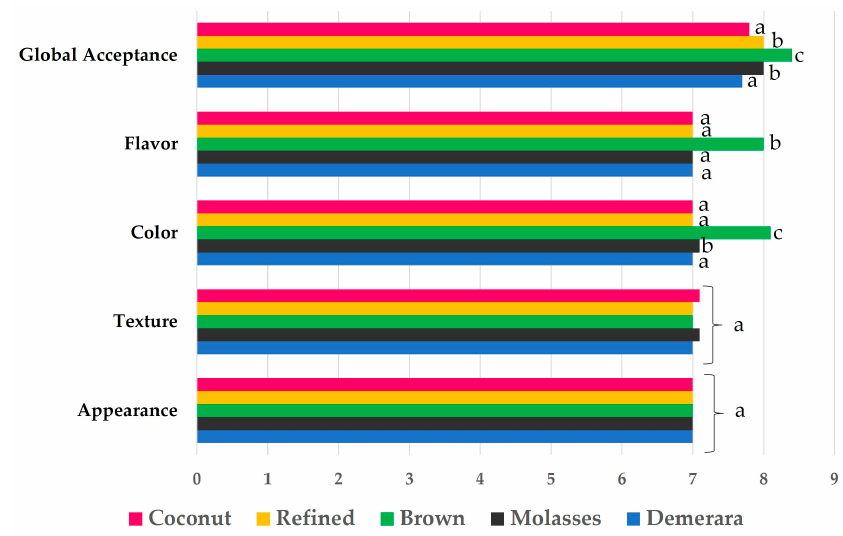
Figure 8. Water kefir beverages sensory evaluation. Different letters for each attribute indicate that there is a statistical difference according to the Tukey test.